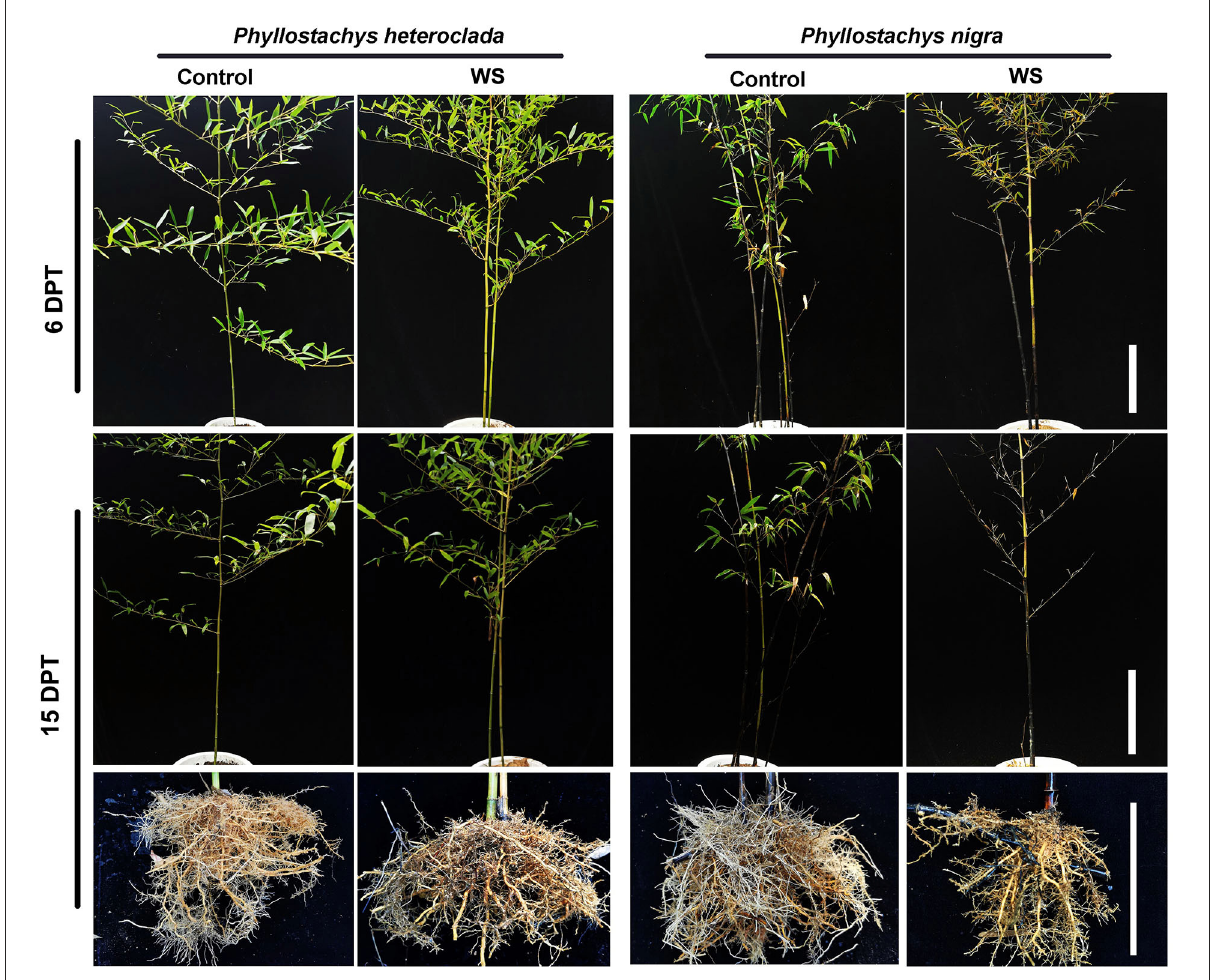
FIGURE4 Morphological comparison of Phyllostachys heteroclada and P. nigra in the riparian zone. Bars, 16cm. WS, waterlogging